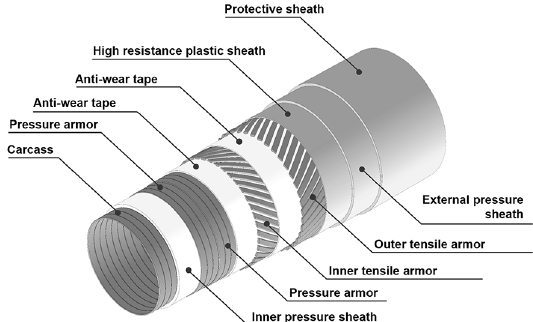
Figure 1. Typical cross section of a flexible pipe. Adapted from